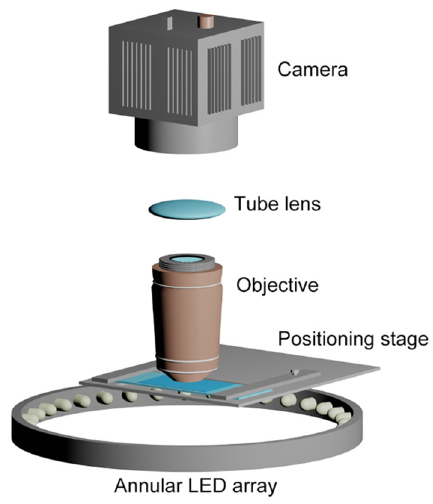
Figure 9. The bright-field microscope with the annular LED array.